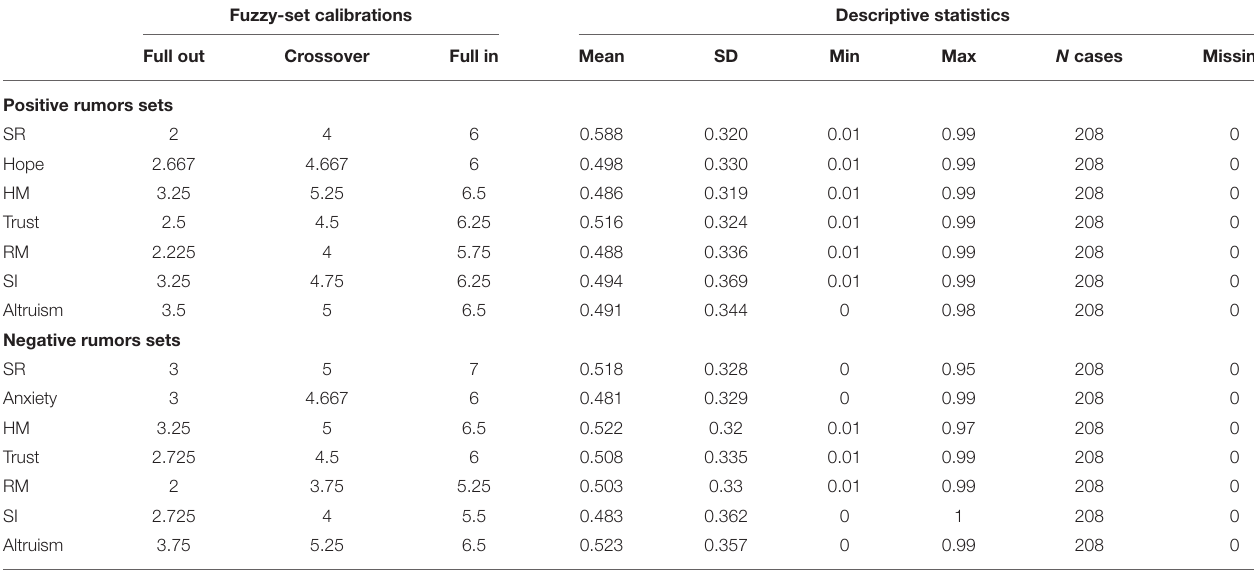
TABLE 2 | Sets, calibrations and descriptive statistics after calibrations regarding positive and negative rumours. Fuzzy-set